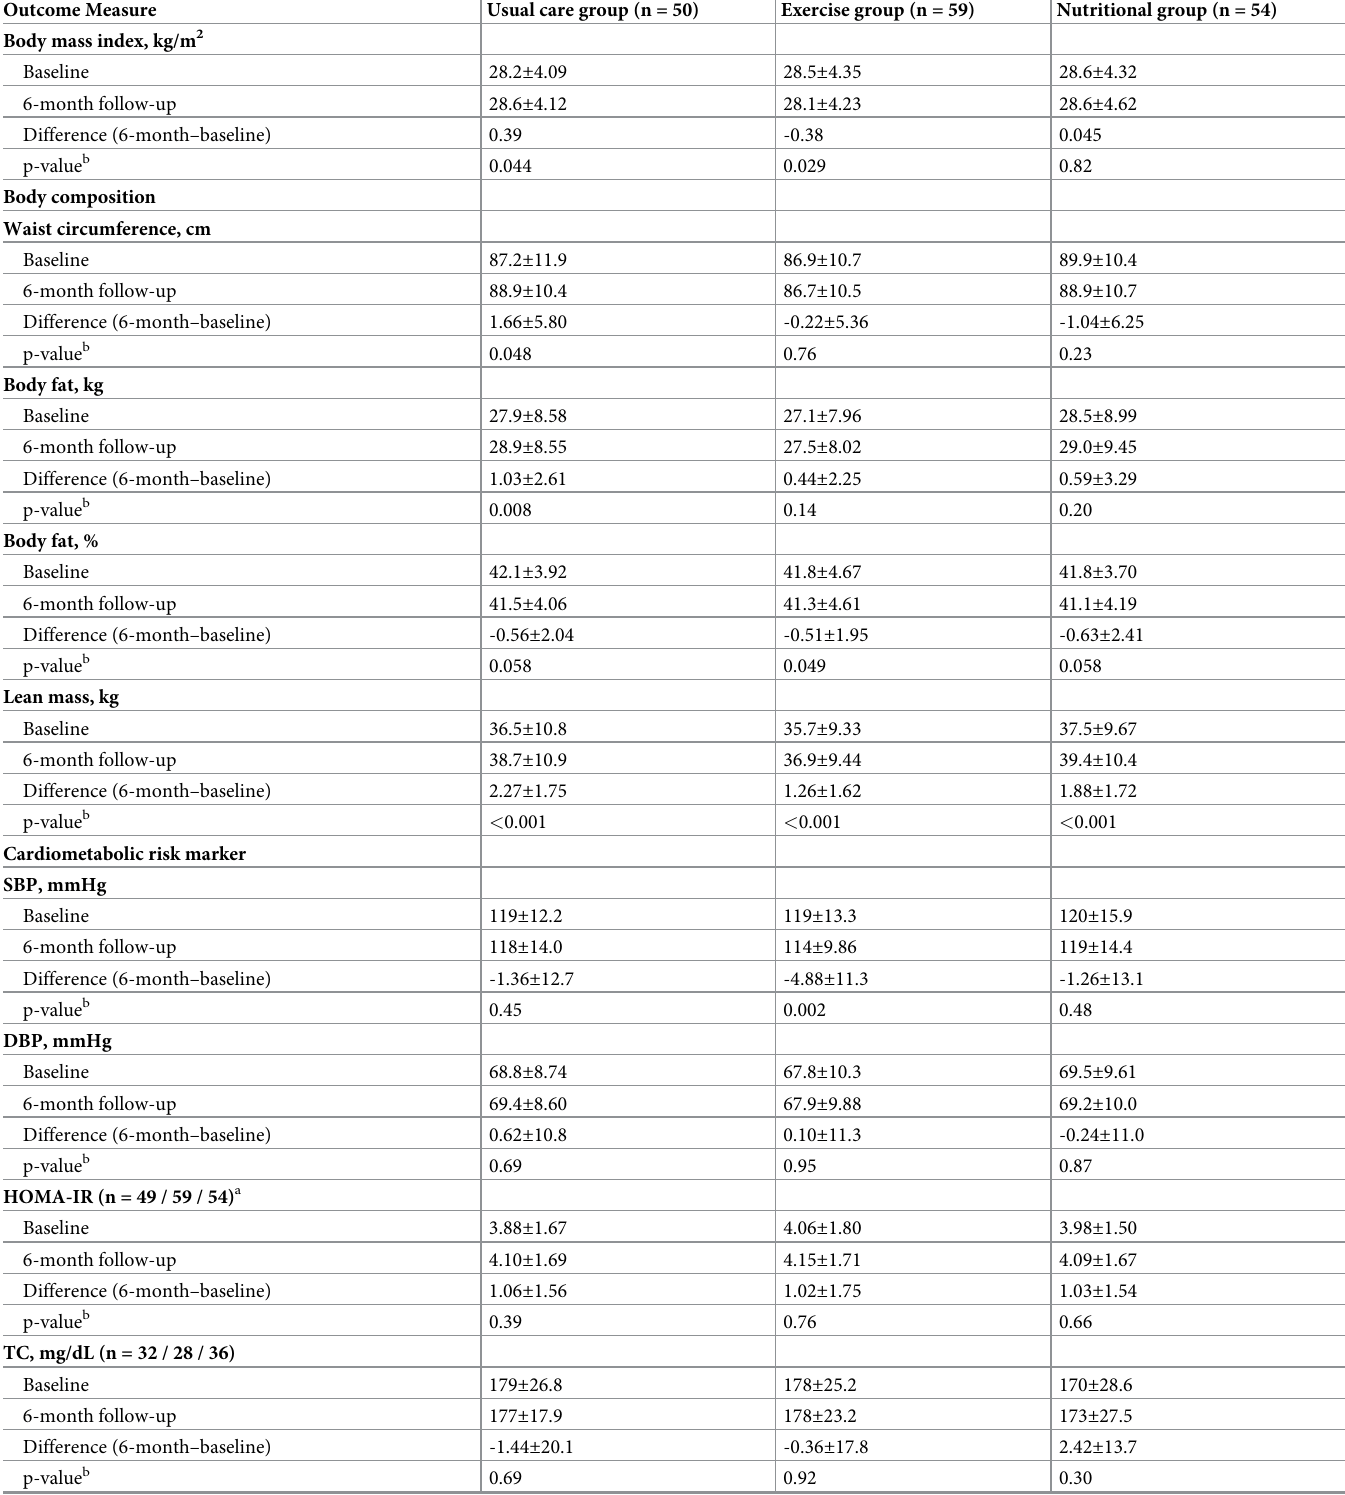
Table 4. Changes in secondary